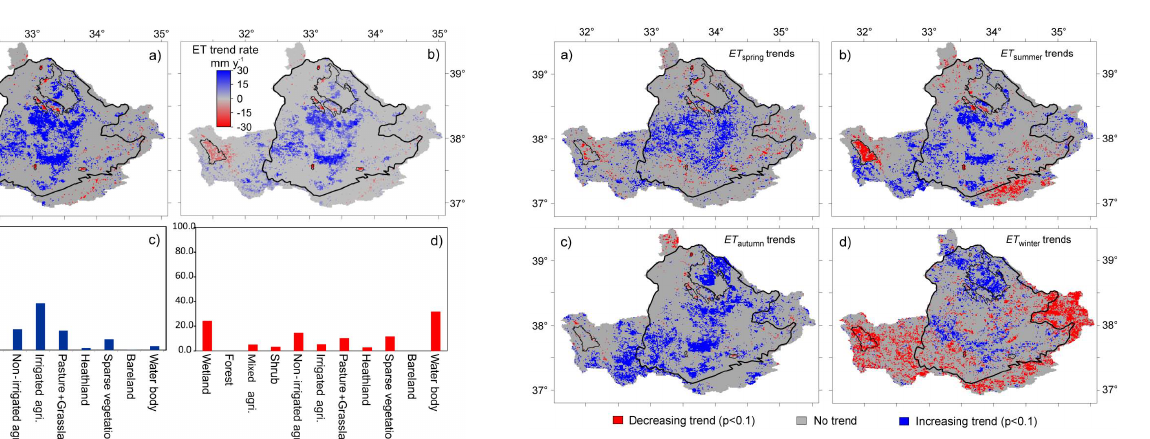
Fig. 5. The distributions of (a) significant trends, and (b) the mag- nitudes of the trends of yearly ET in the Konya Basin, and the his- tograms of the areas with (c) increasing trend, (d) decreasing trend for different land covers.